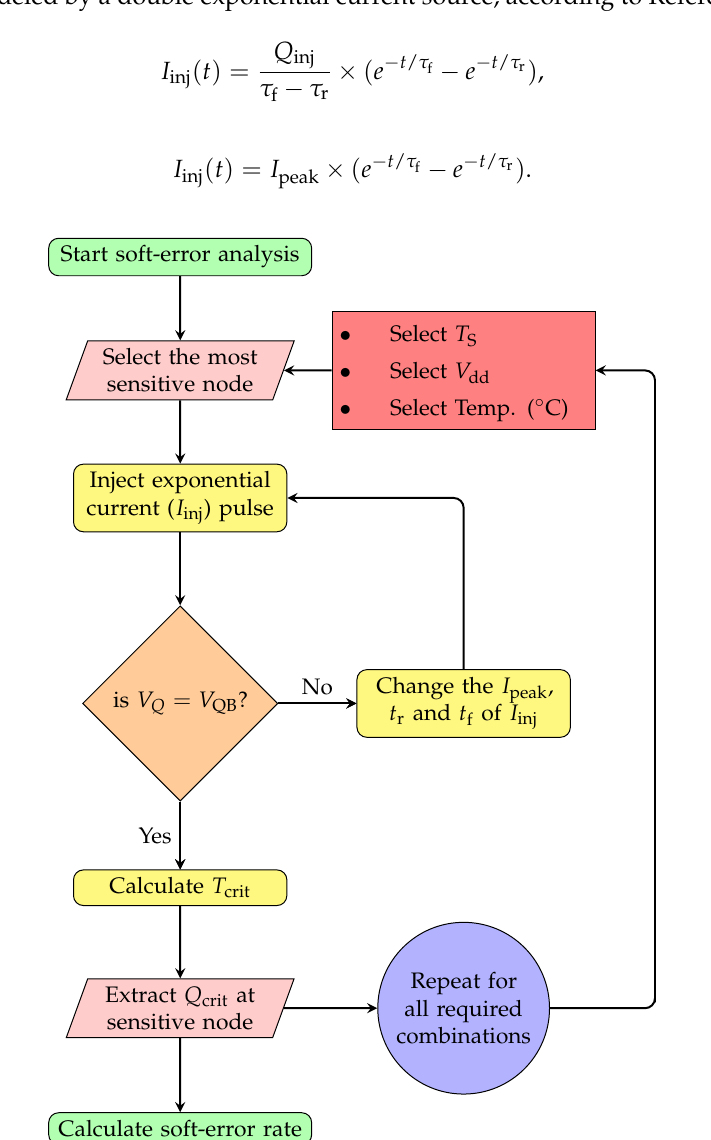
Figure 4. Simulation flow of soft-error analysis with embedded aging